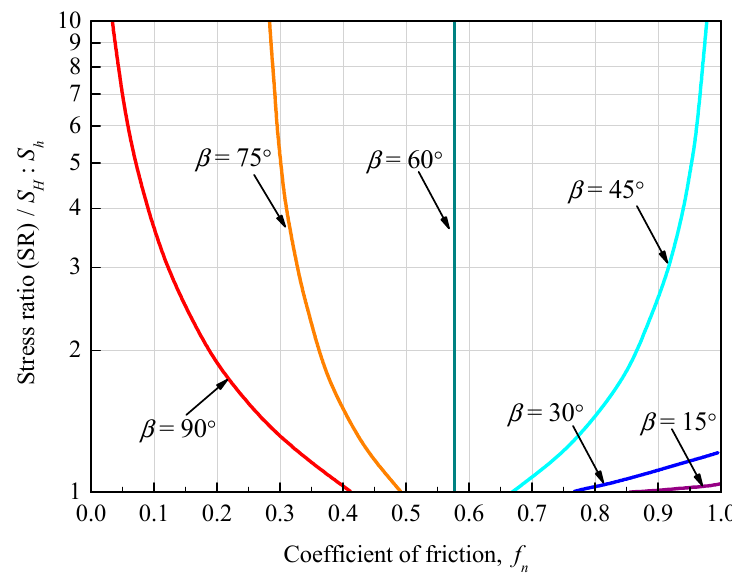
Figure 2. Coefficient of friction versus stress ratio (SR) for non-orthogonal interfaces [20,21].